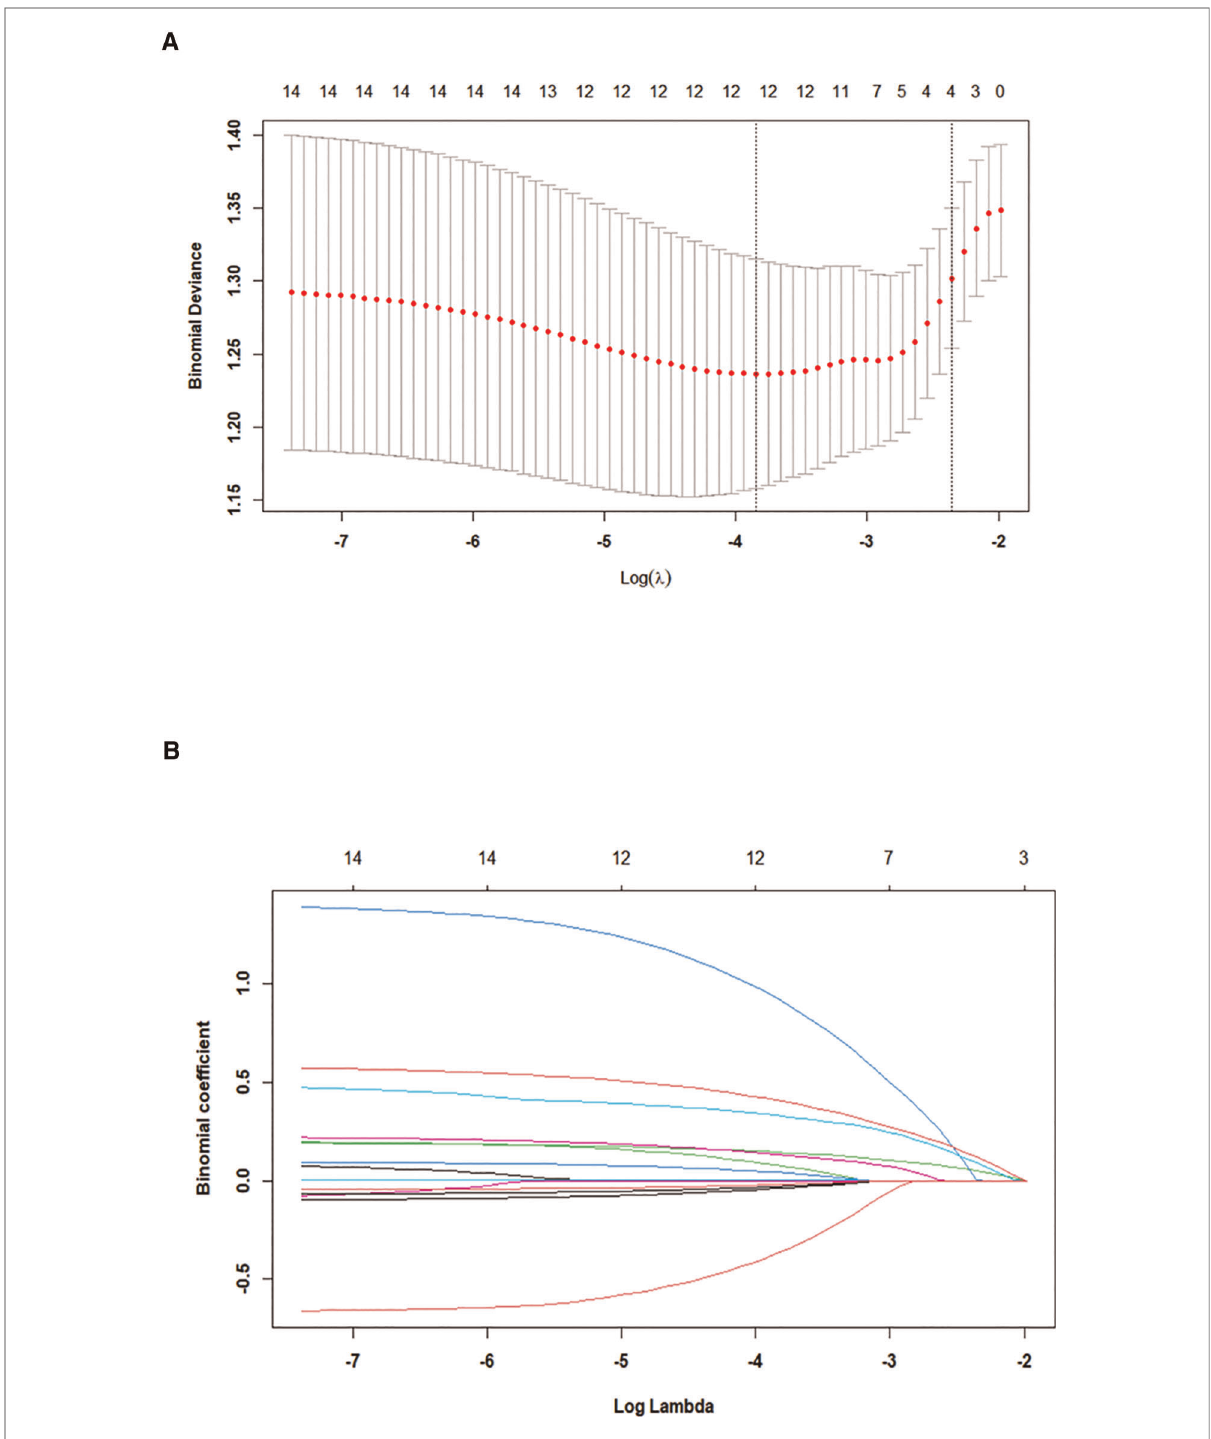
FIGURE 1 Predictor selection using LASSO regression analysis with 10-fold cross-validation. ( A ) Tuning parameter (lambda) selection of deviance in the LASSO regression based on the minimum criteria (left dotted line) and the 1-SE criteria (right dotted line). ( B ) A coef fi cient pro fi le plot was created against the log (lambda) sequence. In the present study, predictors were selected according to the 1-SE criteria (right dotted line), where four non-zero coef fi cients were selected. LASSO, least absolute shrinkage and selection operator; SE, standard